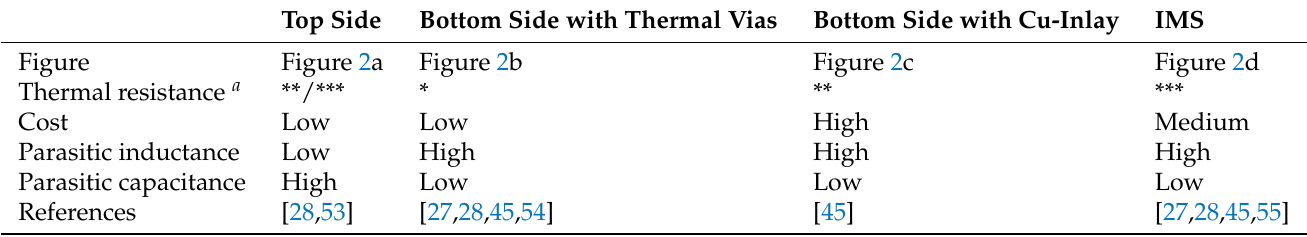
Table 1. Comparison of different PCB